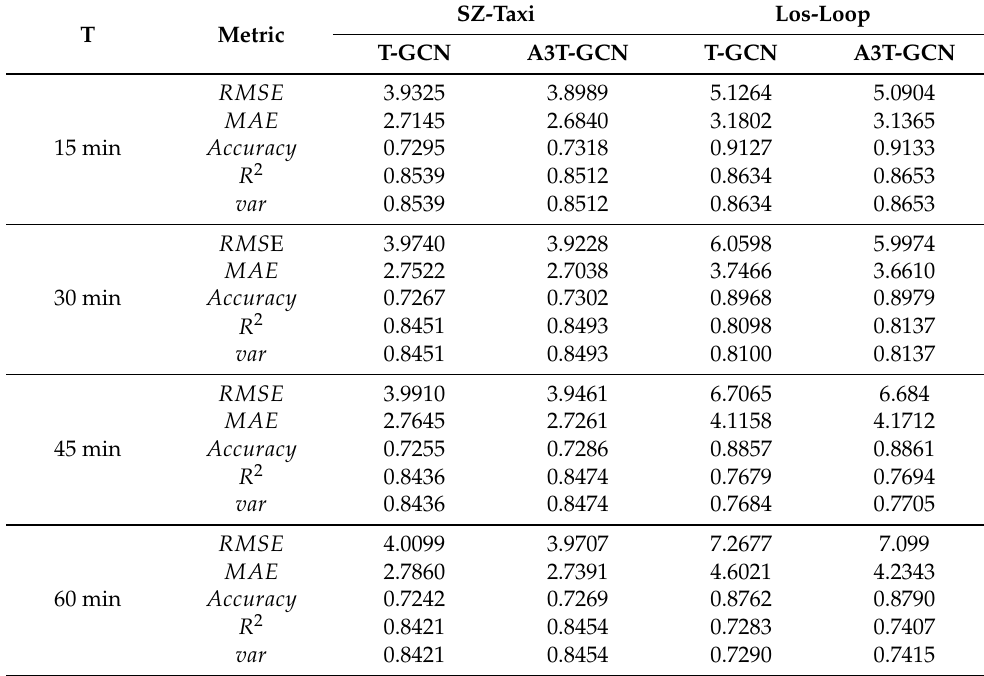
Table 3. Comparison of forecasting results between A3T-GCN and T-GCN under different lengths of time series based on SZ-taxi and